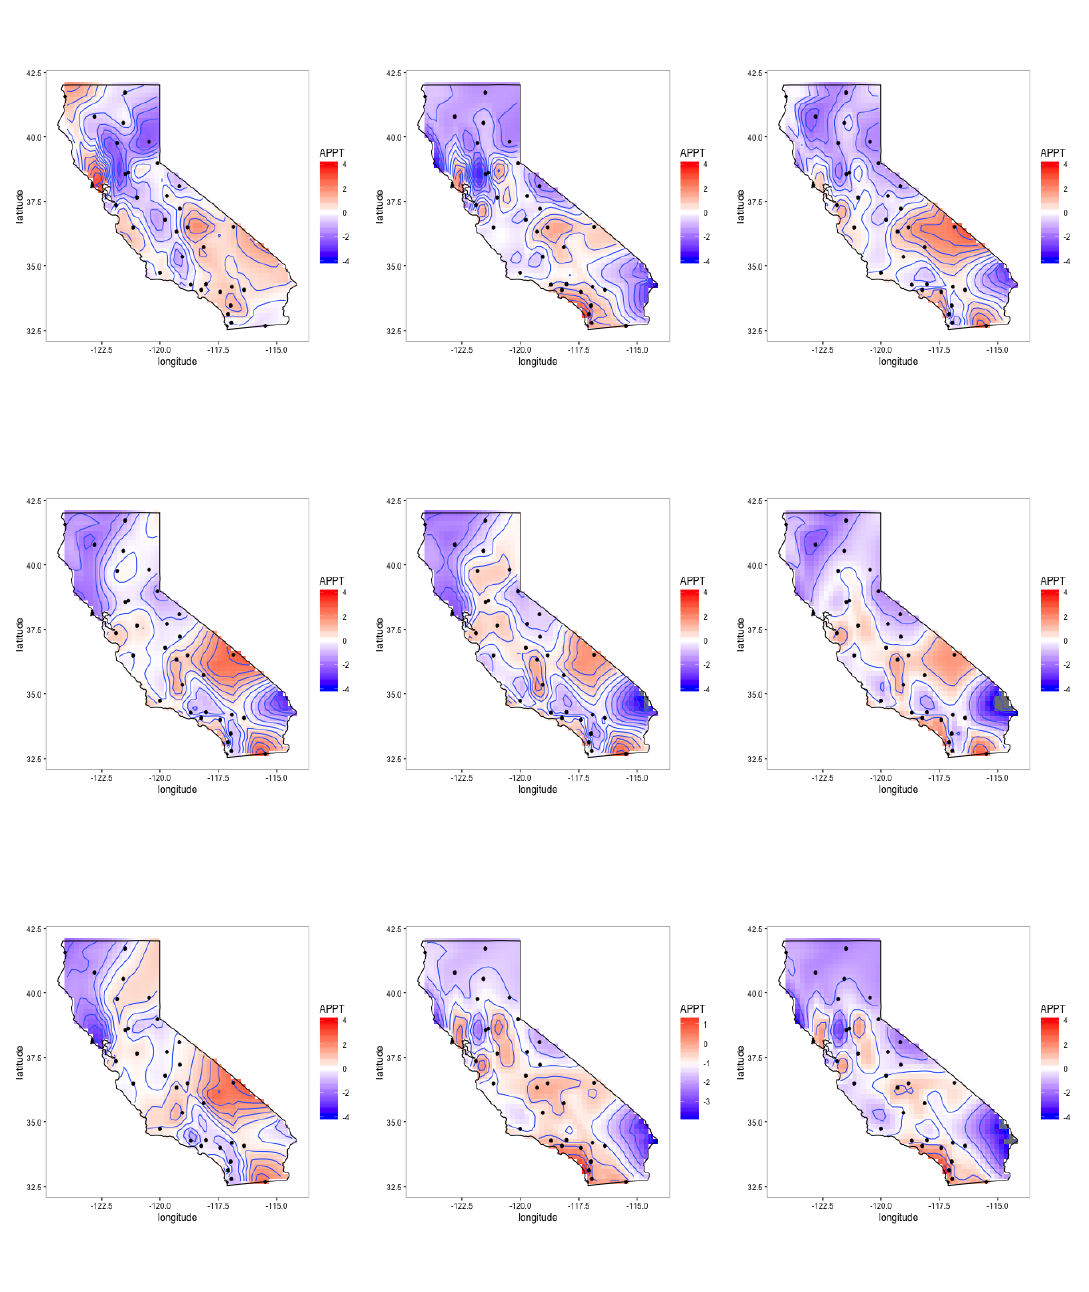
Figure 5. California factor loadings. The Λ p ( s ) are ( 1st row ) Ammonium, Nitrate, Sulfate, ( 2nd row ) Total Carbon Mass, Calcium, Iron and ( 3rd row ) Potassium, Silicon, and Sulfur. The dots represent the STN and IMPROVE monitoring